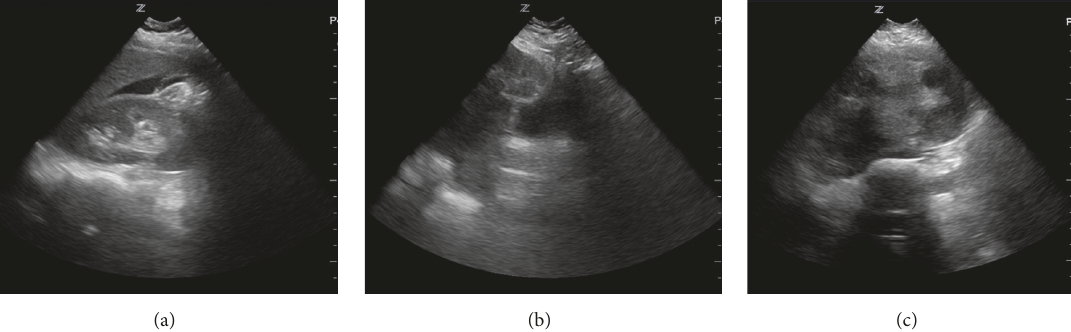
Figure 1: Free fluid noted in right upper quadrant on FAST scan (a). Incidental leiomyomata uteri noted as seen in the sagittal (b) and transverse (c) planes.